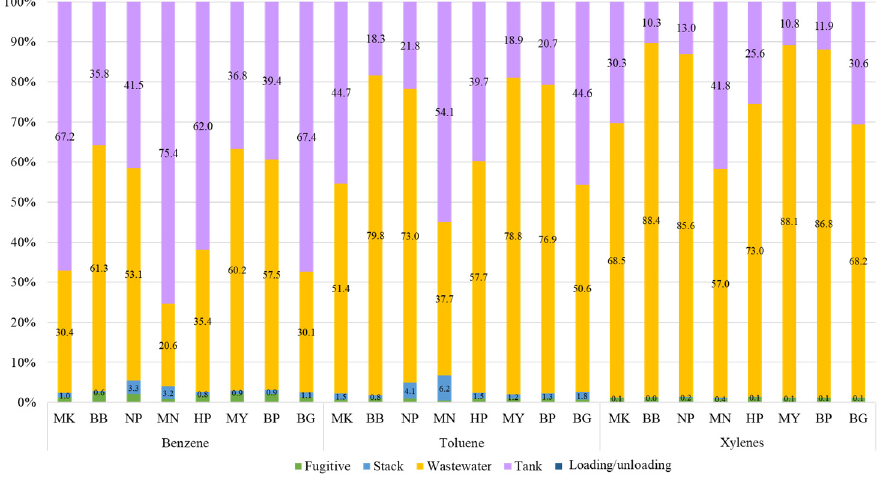
Figure 8. Weighted percentages (%) of source contribution to predicted concentration.